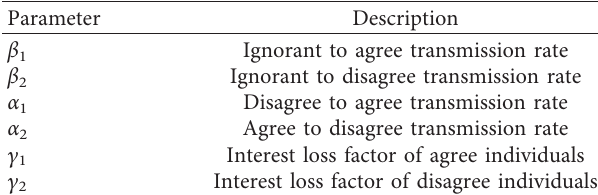
Table 1: Parameter descriptions.